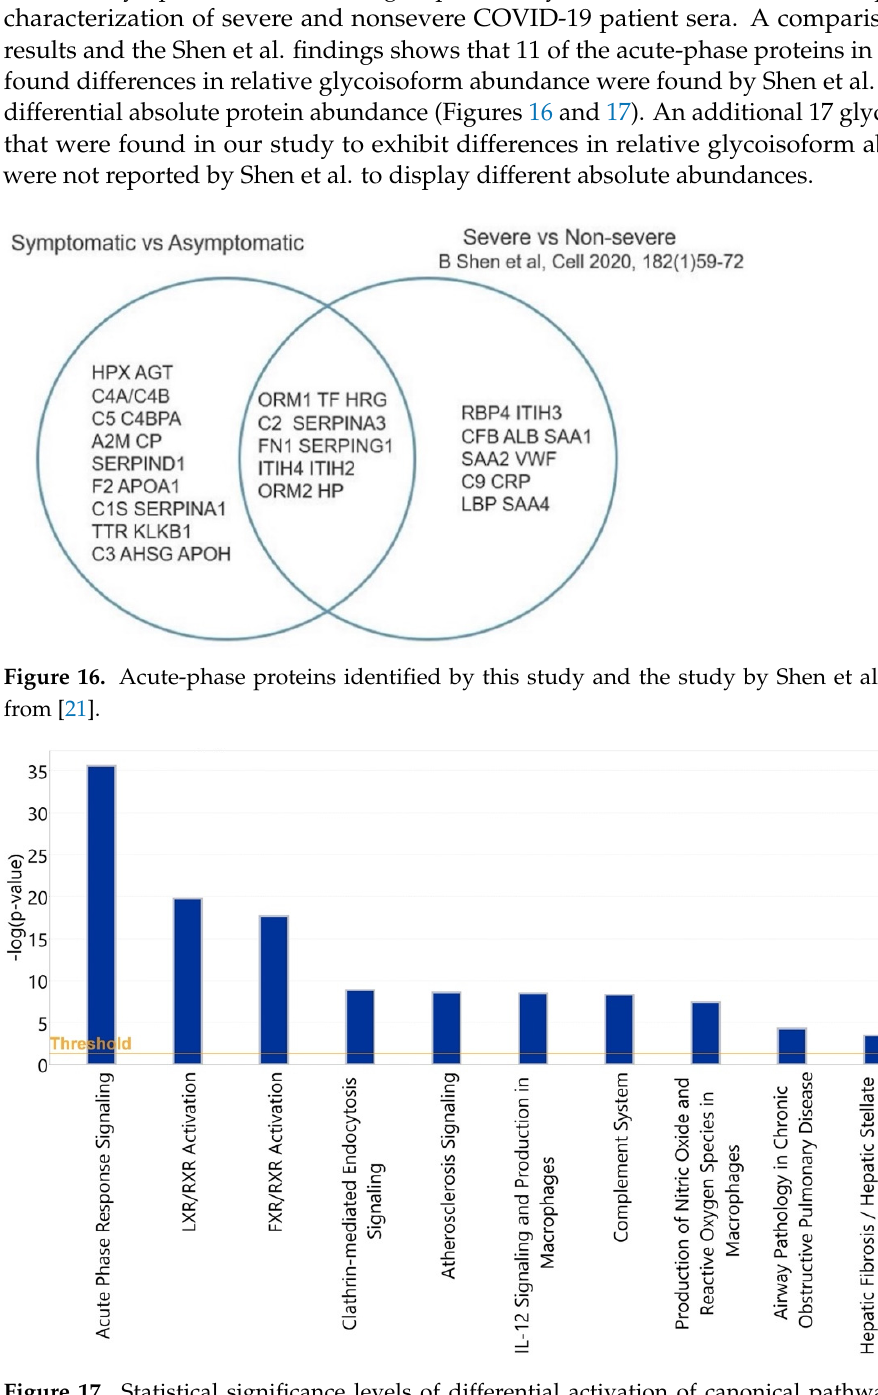
Figure 15. Statistical significance levels of differential activation of canonical pathways among asymptomatic vs. symptomatic COVID-19 patients.